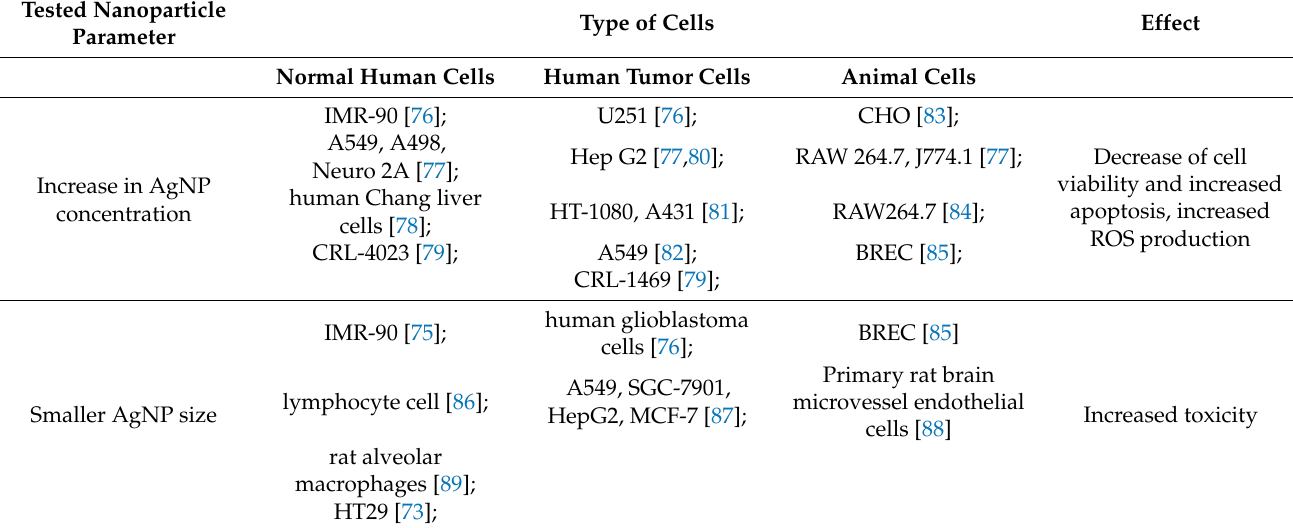
Table 1. Summary of the effects of silver nanoparticles on different types of cell lines: normal human lung fibroblast cells (IMR-90); pulmonary epithelial (A549), renal epithelial (A498), neuronal (Neuro 2A) cell lines; human Chang liver cells; human glioblastoma cells (U251); human hepatocellular carcinoma cells (HepG2); human fibrosarcoma (HT-1080), human skin carcinoma (A431); human lung carcinoma epithelial-like cell line (A549); Chinese hamster ovary cells (CHO); macrophage (RAW 264.7, J774.1) cell lines; mouse peritoneal macrophage cell line (RAW264.7); primary bovine retinal endothelial cells (BREC); immortalized human pancreas duct epithelial cell line hTERT-HPNE (CRL-4023); human pancreatic ductal carcinoma PANC-1 (CRL-1469); human colonic epithelial cell line (HT29); human stomach cancer cells (SGC-7901), and human breast adenocarcinoma cells lines